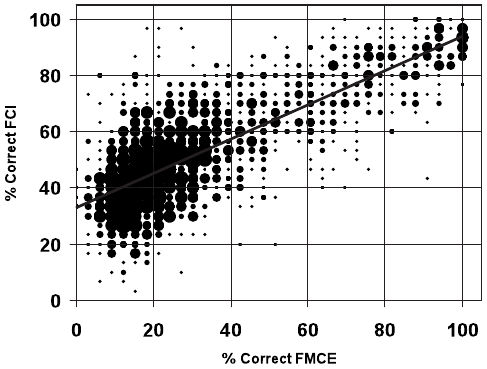
FIG. 1. A “bubble plot” of Preinstruction % correct on the FCI vs % correct on the FMCE. The size of the point indicates how many students had that pair of scores. There are 1617 students in this group. The slope of the best fit line through the data is 0.58 and the y intercept is 35. The correlation coefficient is 0.74. One student had a score of 20% on the FCI and 3% on the FMCE. Five students had a score of 97% on the FCI and a score of 100% on the FMCE.